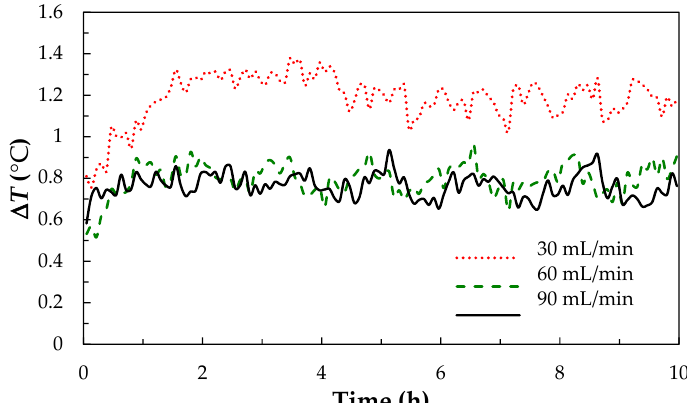
Figure 5. Charge-discharge cyclic diagrams of for V/I RFB. The 1.0 M VOSO 4 /2.0 M H 2 SO 4 was as the positive electrolyte, and iodine/ascorbic acid solutions as the negative electrolyte by carbon paper electrode as the anode and cathode, respectively, N-117 membrane as a separator with a serpentine-type flow field at a current density of 40 mA cm − 2 with different flow rate by monitoring of the ITI ( a ) 30 mL/min, ( b ) 60 mL/min, ( c ) 90 mL/min.